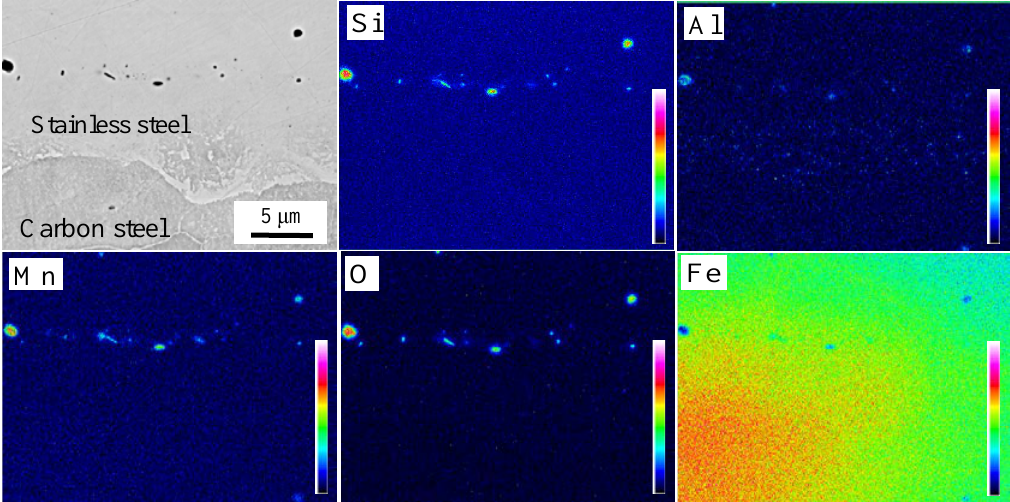
Figure 9. Distribution of elements in oxide after brush grinding.